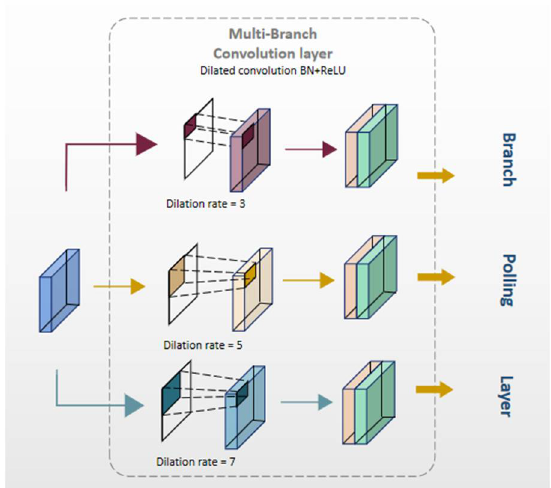
Figure 6. The structure of the FEM [22].